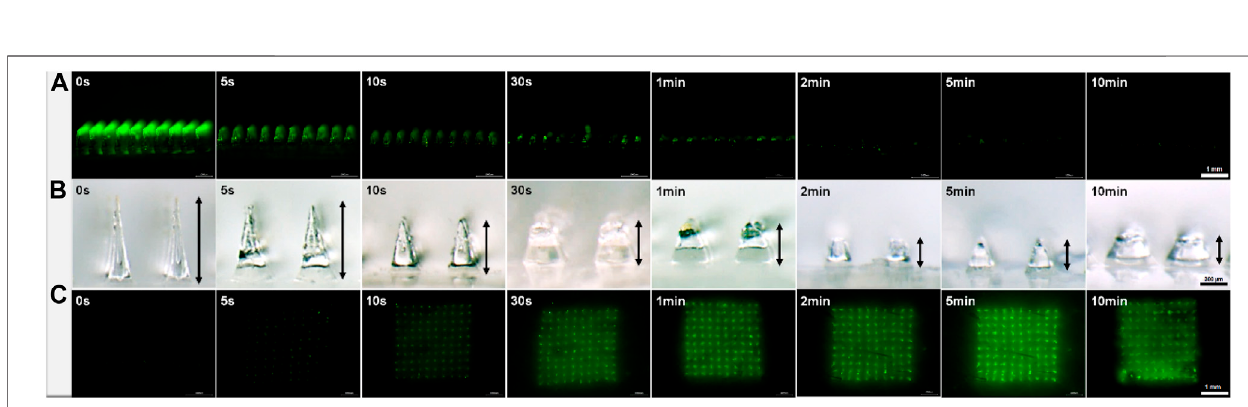
TABLE 1 | In vitro test of FITC-Insulin delivery ef fi ciency in the porcine cadaver skin. Concentration of drug solution (mg/ml)